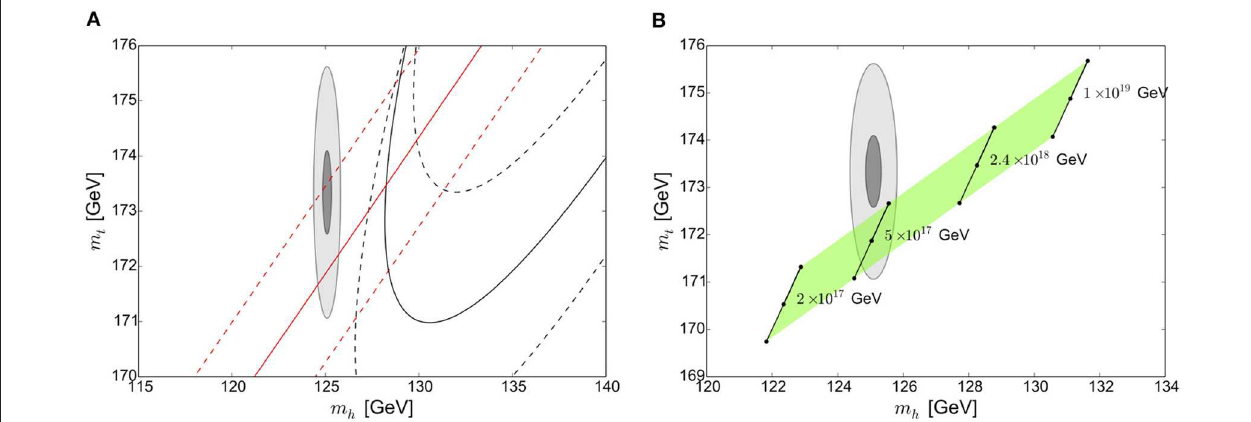
M Pl M Pl FIGURE 3 | (A) λ 0 (red) and β λ 0 (black) contours in the m h = = (cid:0) (cid:1) (cid:0) (cid:1) Mass values that satisfy both boundary conditions at various UV scales. The green region corresponds to a 1 σ uncertainty in α s . Ellipses show the experimentally allowed values of m t and m h with 1 σ (dark gray) and 3 σ (light gray) uncertainty. These plots originally appeared in McDowall and Miller [